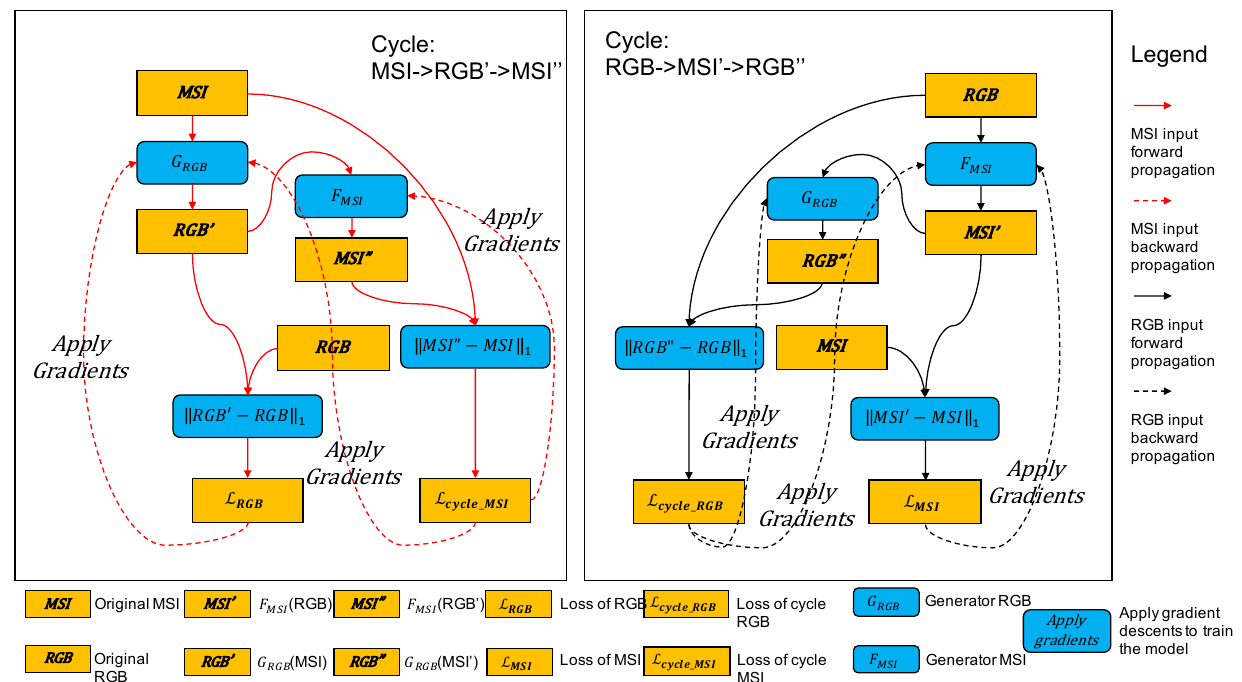
Figure 6. The detailed training flow of